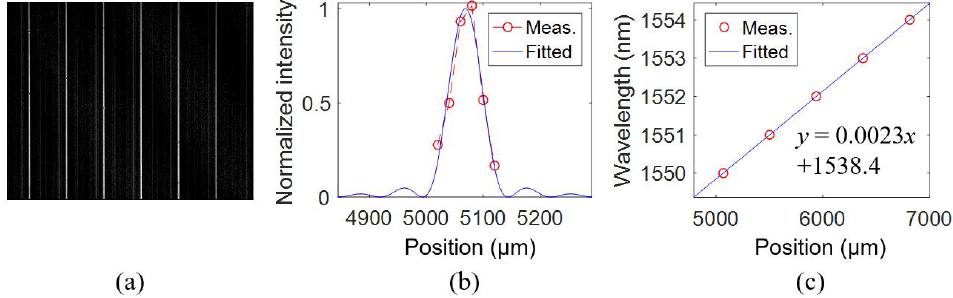
Figure 13. Measured results of WSL3. ( a ) Spectral lines at 1550 nm. ( b ) Measured and fitted far-field distributions with an FWHM of 0.15 nm at 1550 nm. ( c ) Measured and fitted wavelengths at different pixel positions.